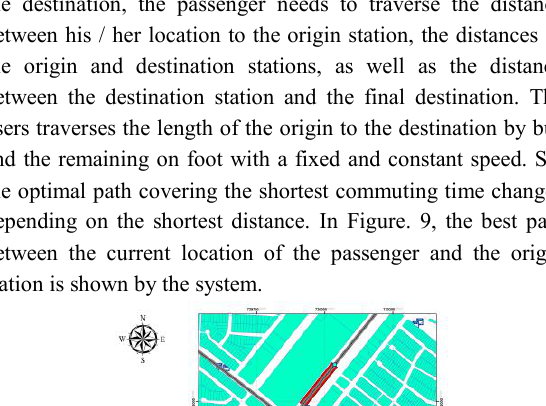
Figure. 6, evaluating distribution of the bus stations numbered